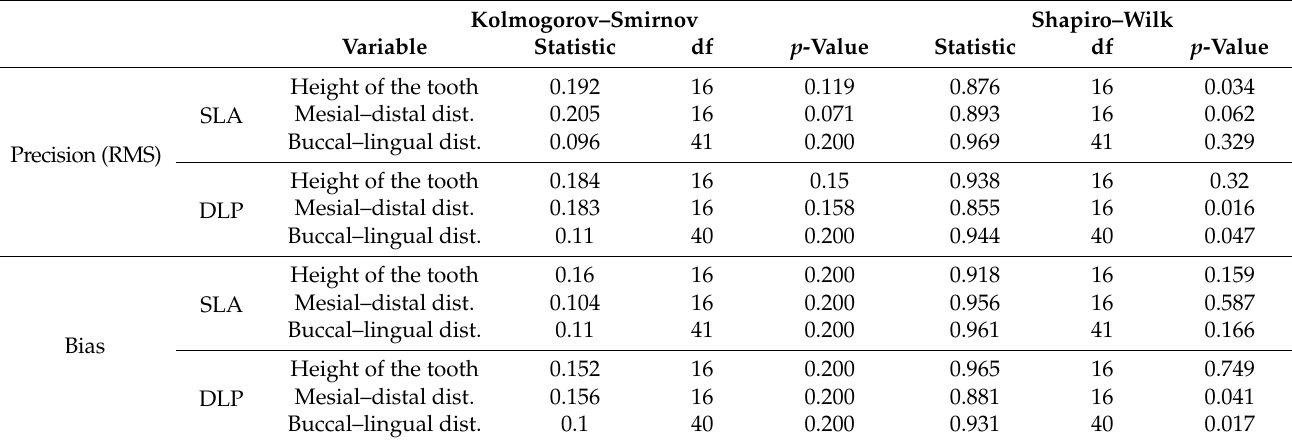
Table 2. Normality tests for the data of the analyzed